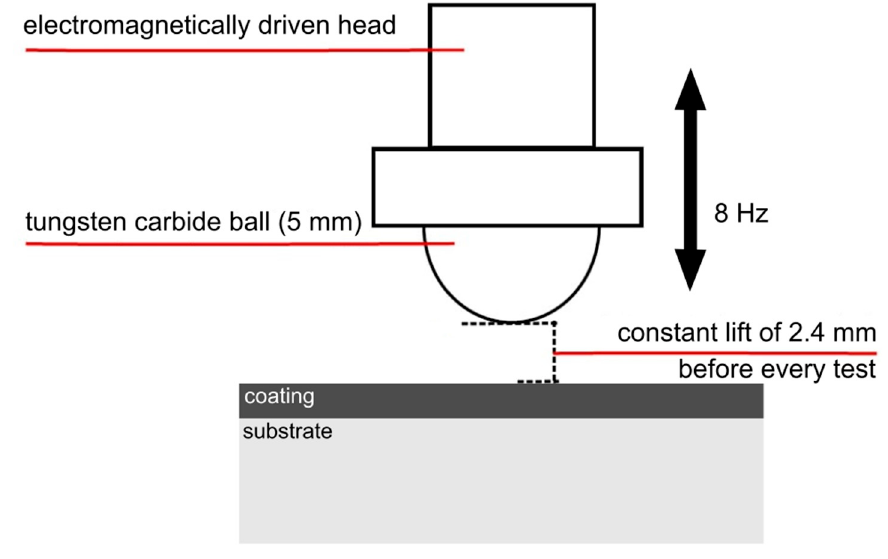
Figure 2. Scheme of the dynamic impact tester.